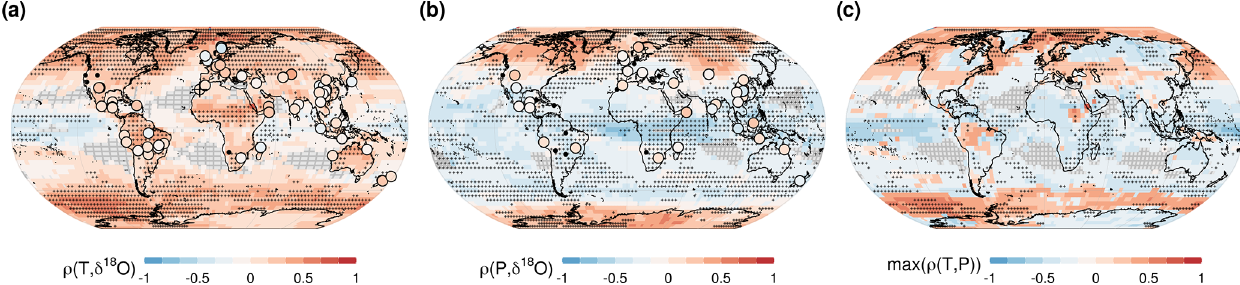
Figure 5. Correlations between SWI and modeled temperature (a) and precipitation (b) time series in each grid box. The background shows the average over all five simulation correlation estimates between annual δ 18 O iw and simulated annual temperature per grid box (a) and for precipitation (b) . Crosses indicate grid boxes where correlation estimates for four or more models have the same sign as the averaged estimate over all simulations. Symbols indicate the mean correlation of the simulated temperature (precipitation) of all model simulations to the recorded δ 18 O speleo at record resolution. Crossed circles mark sites where more than four models agree in the mean sign of the correlation to δ 18 O speleo . Black circles indicate the location of those speleothems in the last millennium subset that show no significant correlation to any model. In (c) the map shows positive correlation estimates where | ρ ( δ 18 O , T) | is larger than | ρ ( δ 18 O , P) | (and vice versa for negative